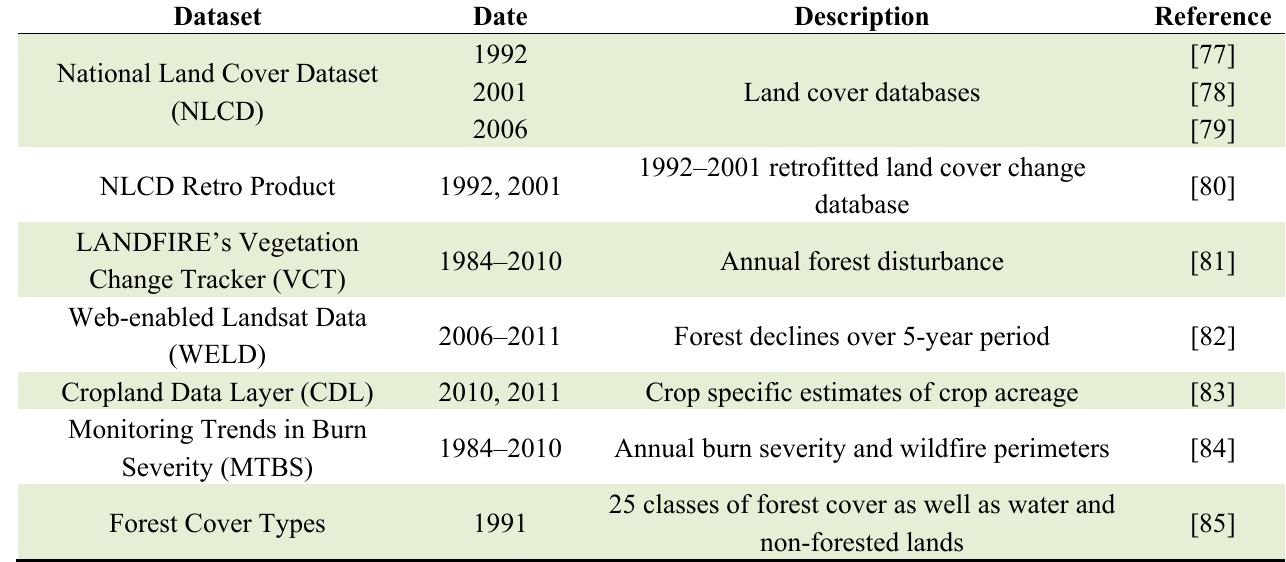
Table 1. National spatial datasets used in the harmonized land use and land cover (LULC) map